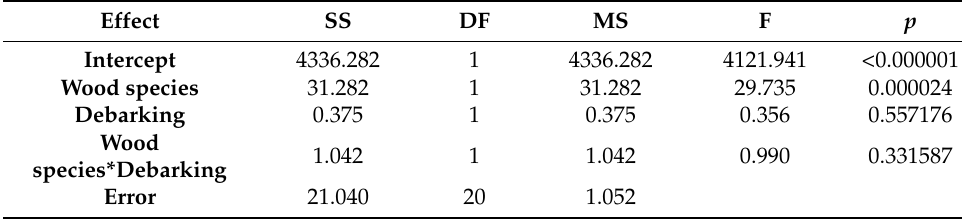
Table A6. ANOVA table for the median value of the particle size